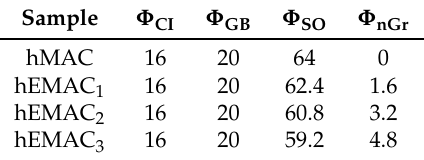
Table 2. Mass fractions Φ (wt%) of CI, gauze bandage (GB), SO and nGr inside hybrid magnetic composites (hMACs) and hybrid electromagnetic active materials (hEMACs).